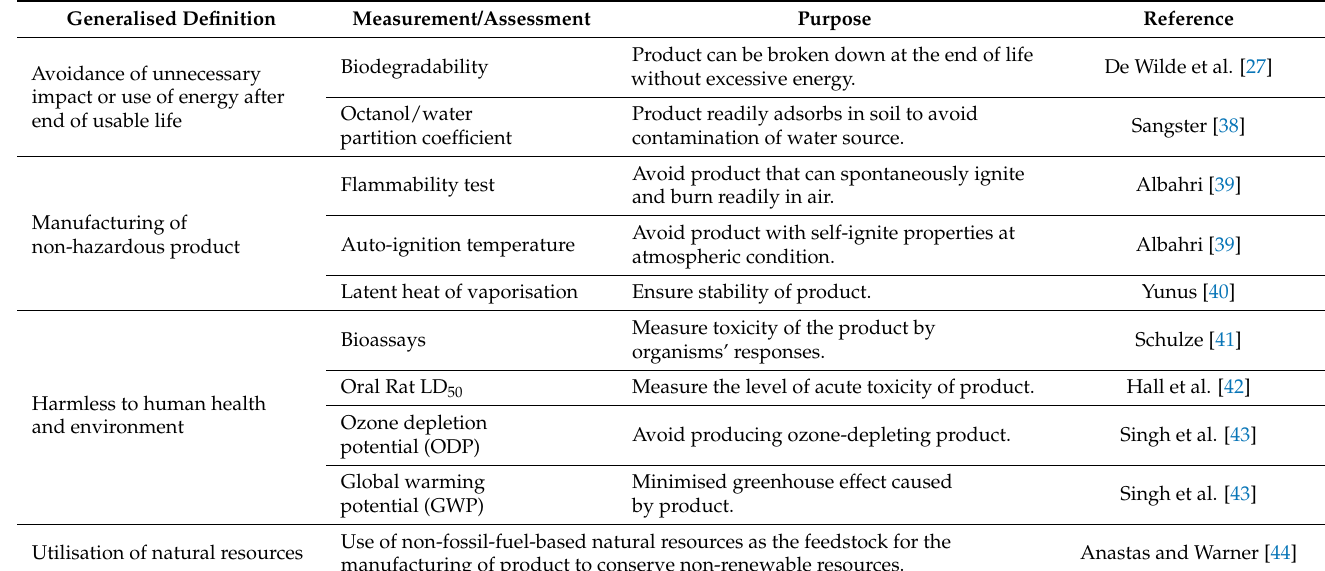
Table 1. Green definitions of products with measurement/assessment method.